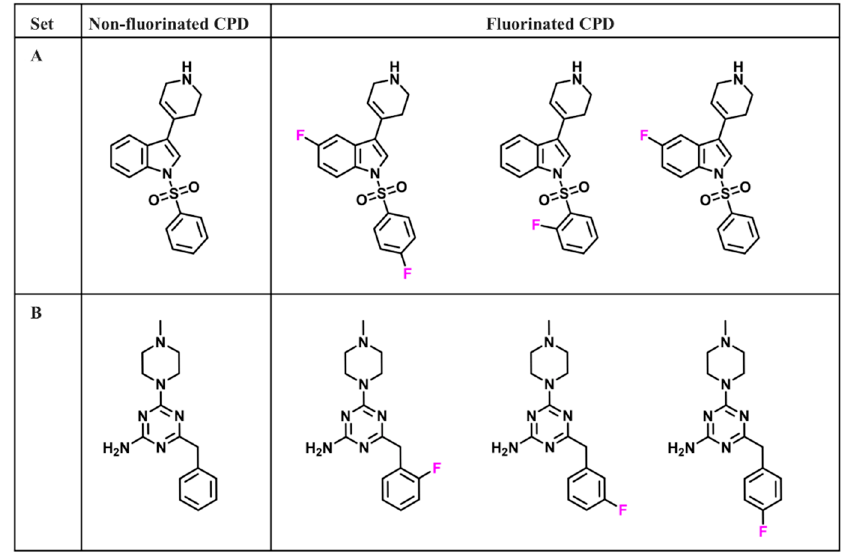
Figure 1. FSAR sets. Two exemplary FSAR sets A and B with ligands active against serotonin 6 (5-HT6) receptor are shown. On the left side, the non-fluorinated active compound of each set is shown and on the right side, corresponding active fluorinated analogues are shown.